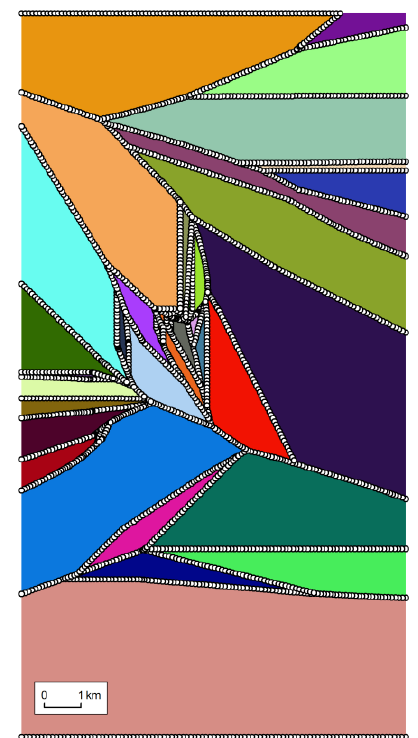
Figure 2. Nodes (white points) of the cross sections derived from the boundaries of modelling area segments (shown by colours equally to the Fig.